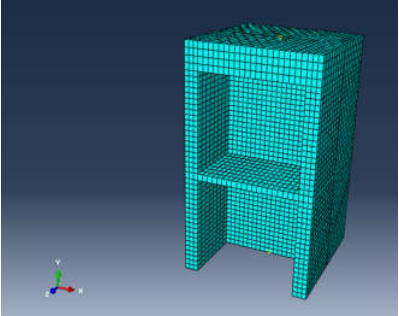
Figure 1. The meshed state of the damper in 3D mode.